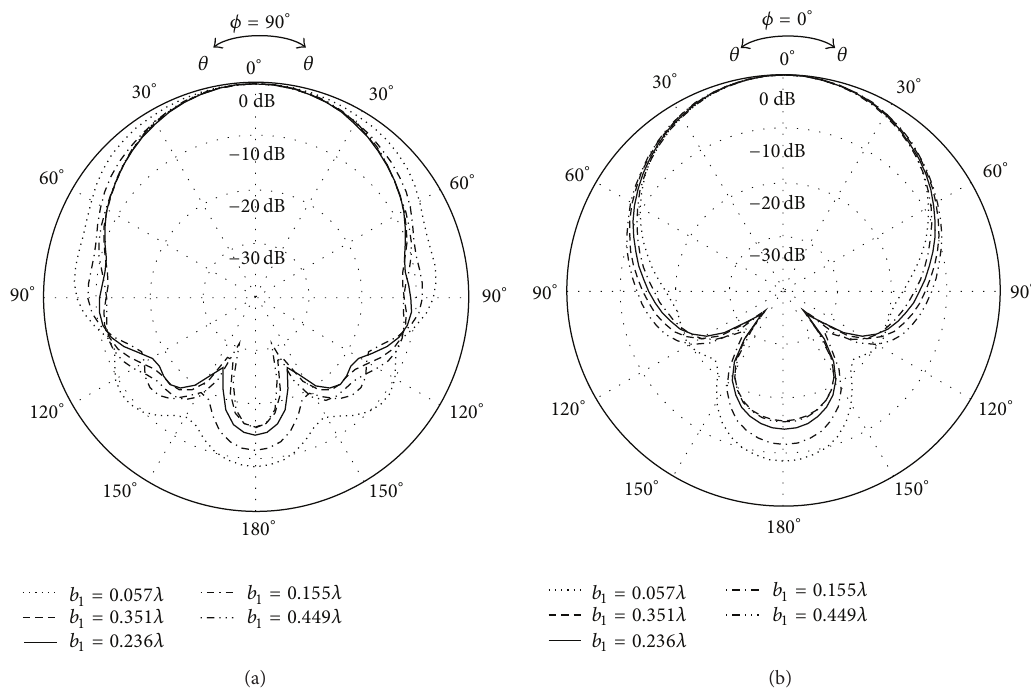
Figure 14: Simulated radiation patterns for various parasitic coupling aperture heights ( 𝑏 1 ) at the center frequency of 2.45 GHz in (a) the 𝐸 -plane and (b) the 𝐻